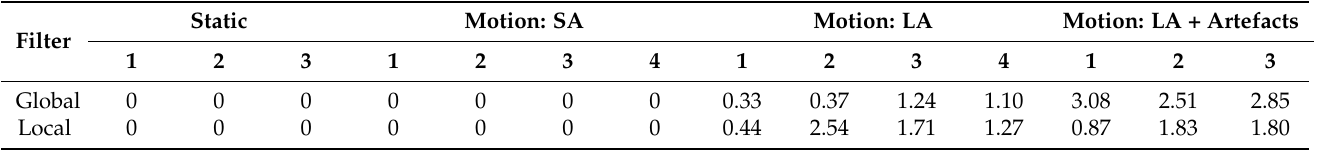
Table 2. Reference void failure rates (%) for the validation experiments. Static: tests (1–3) are with neutron flux transmission along the shorter axis (SA) of the body, the longer axis (LA), and the latter with an extra distance to the scintillator. For moving body imaging, tests with an extra body-to-scintillator distance are (3–4) for SA and (4) for LA. Tests with LA and synthetic artefacts are based on data from LA runs (2) and (4).